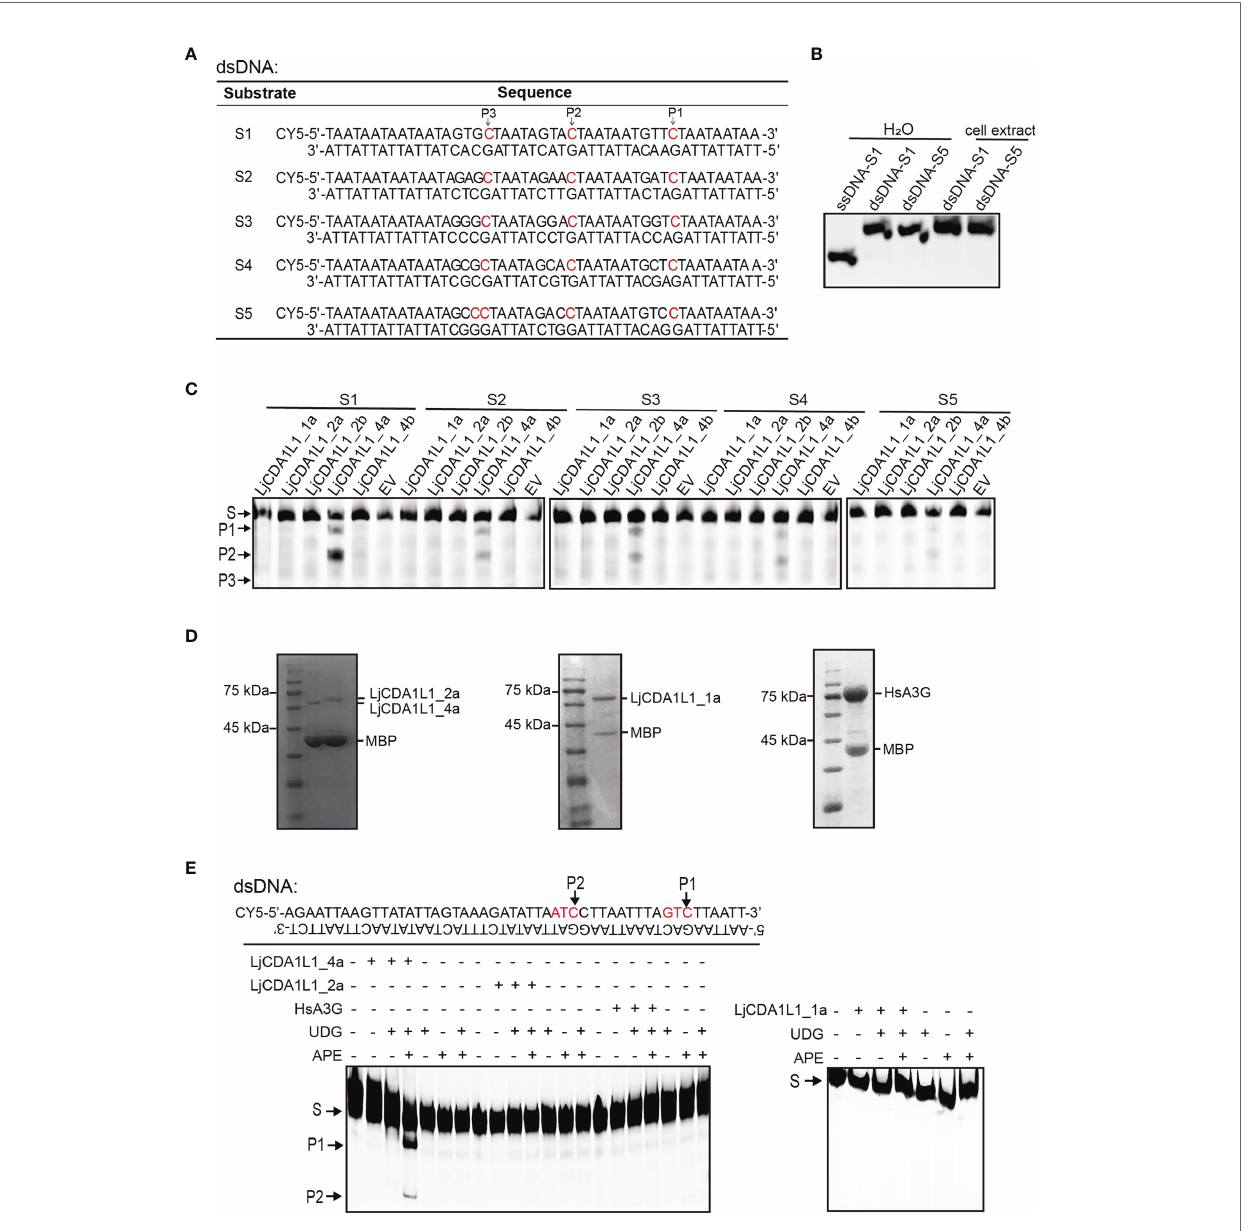
FIGURE 5 | Cytidine deaminase activity of LjCDA1L1s on dsDNA in vitro . (A) The table indicates the used dsDNA substrates labeled with CY5. Arrows represent the target C. (B) The migration of ssDNA and dsDNA detected by native electrophoresis. (C) Cytidine deaminase activity of LjCDA1L1s on dsDNA using cell lysates from LjCDA1L1s expressing 293T cells. S, substrate; P, product; EV, empty vector. (D) The puri fi ed LjCDA1L1_4a, LjCDA1L1_1a, LjCDA1L1_2a, and HsA3G proteins from 293T cells were shown by SDS-PAGE and Coomassie blue staining. (E) Cytidine deaminase activity of the puri fi ed proteins on dsDNA in vitro . Arrows represent the target C. S, substrate; P, product. All results were representative of three independent biological